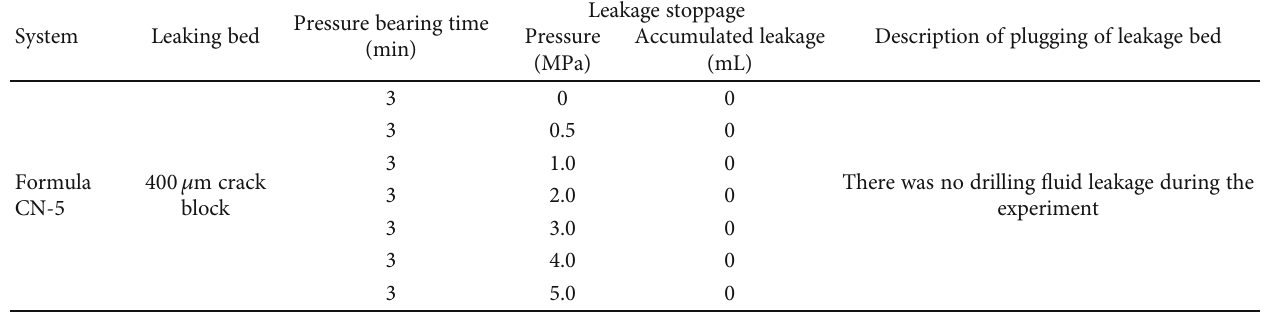
Table 12: Fracture sealing evaluation results of strong plugging drilling fl uid.